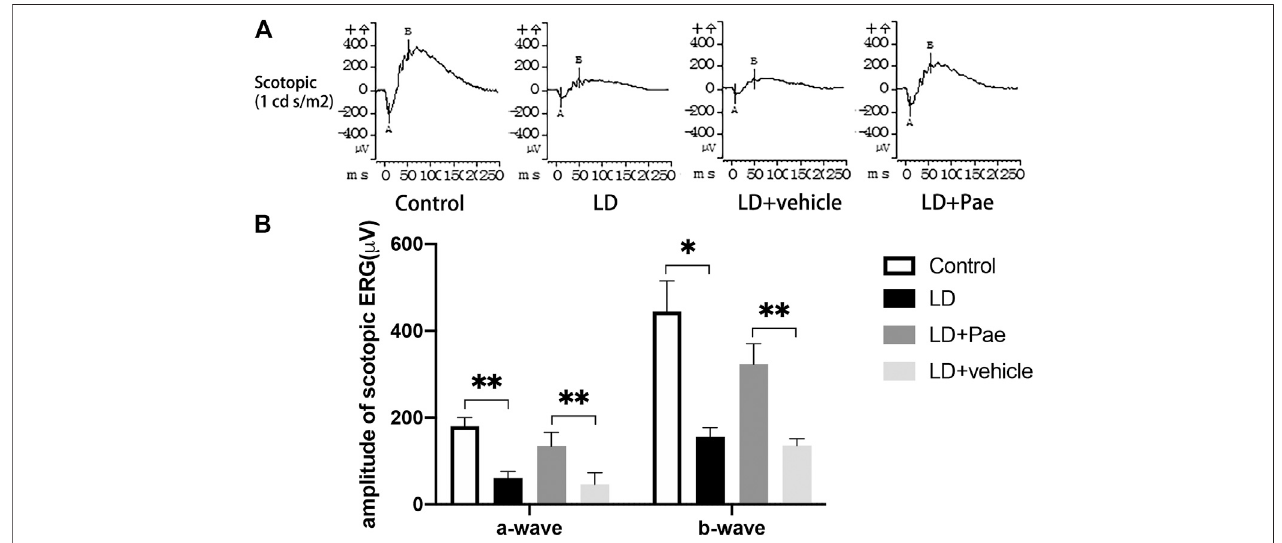
FIGURE 2 | Pae protects RP function from LD. (A) Representative a- and b-waveforms of scotopic ERG. Light injury caused dysfunction of RP, showing by the drastically decreased amplitudes of a- and b-waves. Pae protected the RPs by sustaining the waveforms partly. (B) Statistical analysis of a- and b-waves of scotopic ERG. Data show mean ± SD. ( n (cid:1) 6 – 9 for each group) * p < 0.05, ** p <